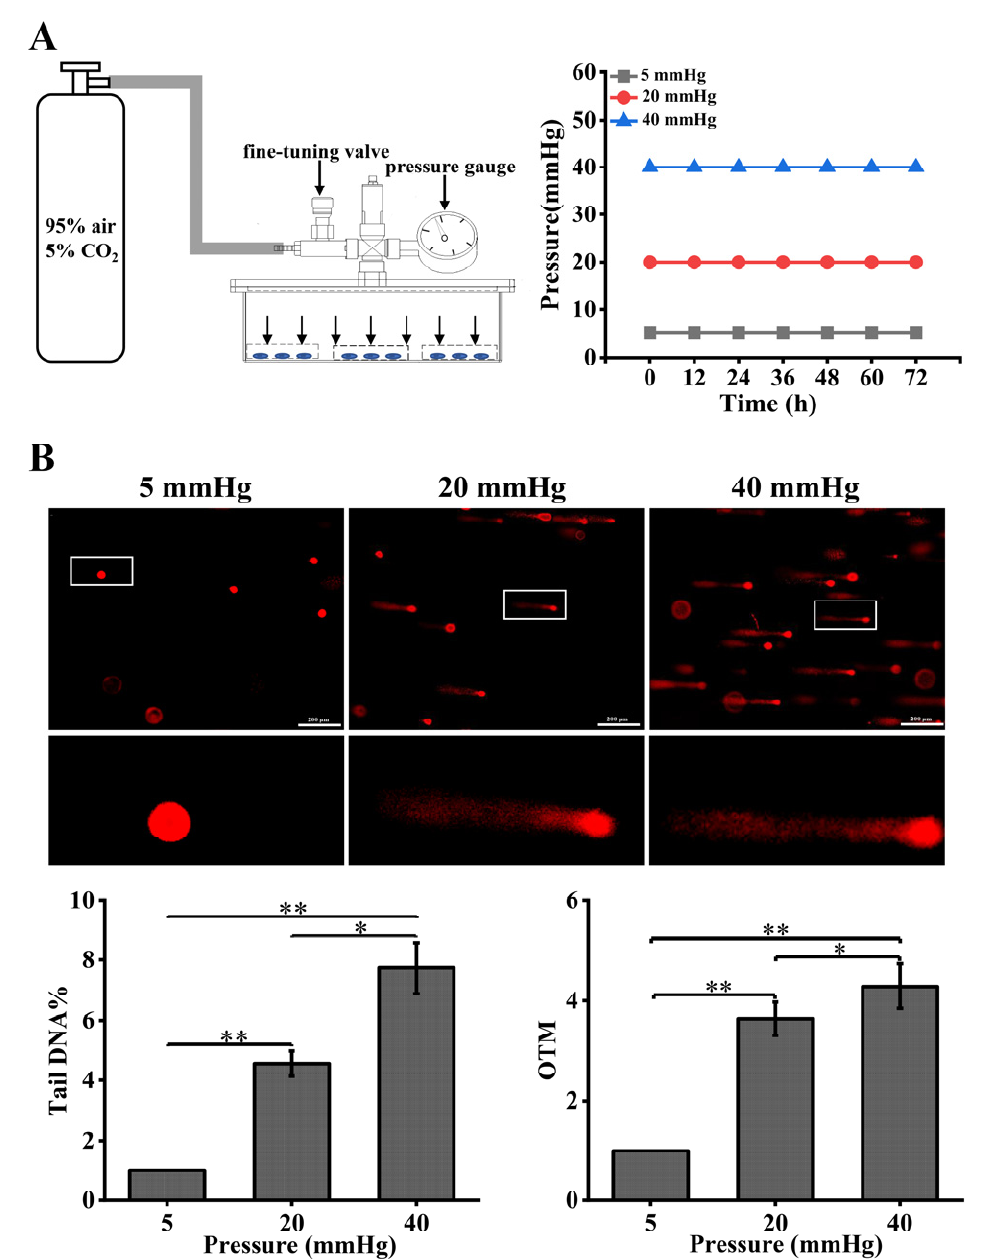
Figure 1. Pressure loading aggravates DNA damage in hepatocytes: ( A ) schematic diagram of the experimental apparatus for pressure and changes in pressure over time in the pressure loading de- vice; ( B ) DNA damage in hepatocytes cultured for 48 h under different pressure levels (5, 20, 40 mmHg) was examined using the comet assay. OTM and tail DNA% were used to calculate the de- gree of DNA damage (scale bar, 200 µm). Data are expressed as the mean ± SD. n = 3, * p < 0.05, ** p < 0.01.